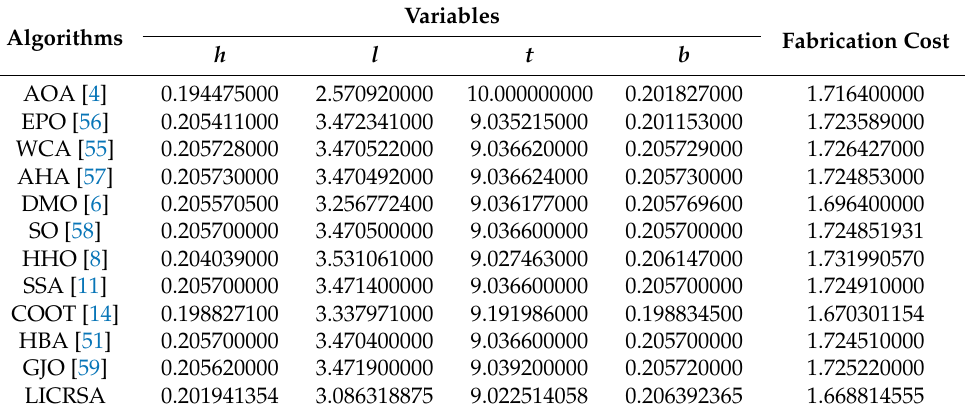
Table 9. Numerical comparison of the results obtained for the welded beam design problem in the